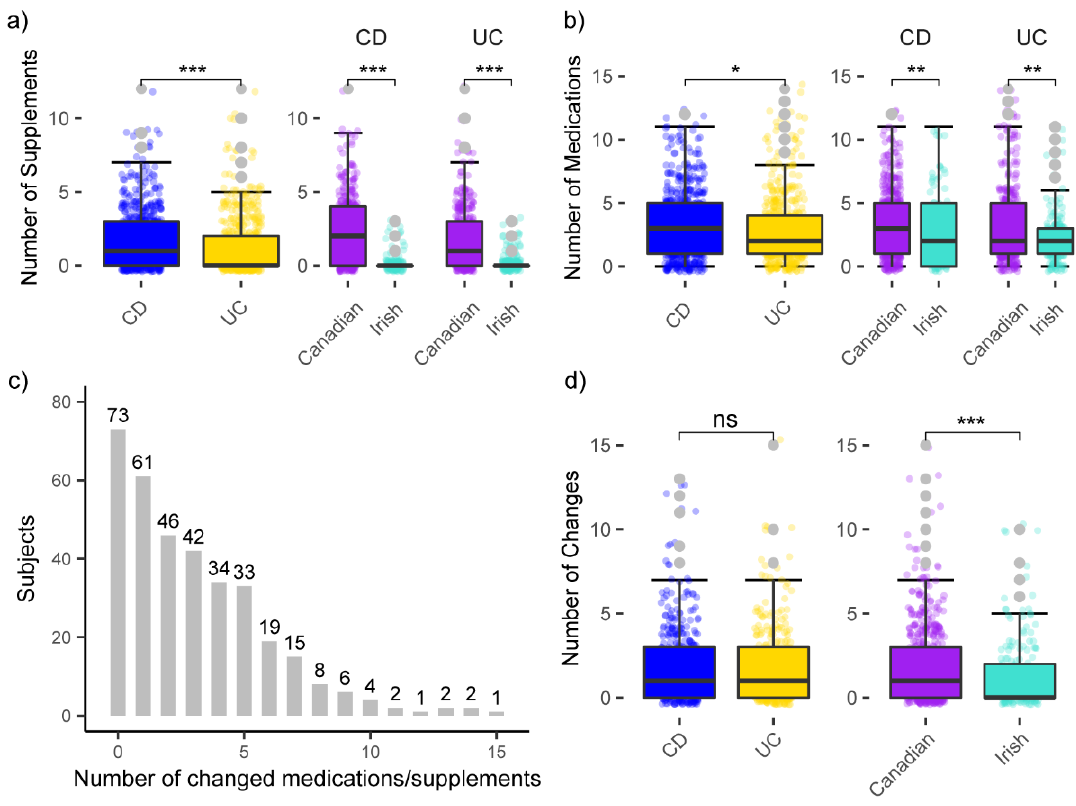
Figure 4. Comparison of the amount of ( a ) supplements and ( b ) medication taken per person and time point; ( c ) histogram of changes in medications and supplements with ATC classification per subject over the course of the study; ( d ) comparison of changes in medications and supplements between persons with differing IBD-subtype and from different geographic locations; Wilcoxon test: ns p > 0.05; * p < 0.05; ** p < 0.01; *** p < 0.001.